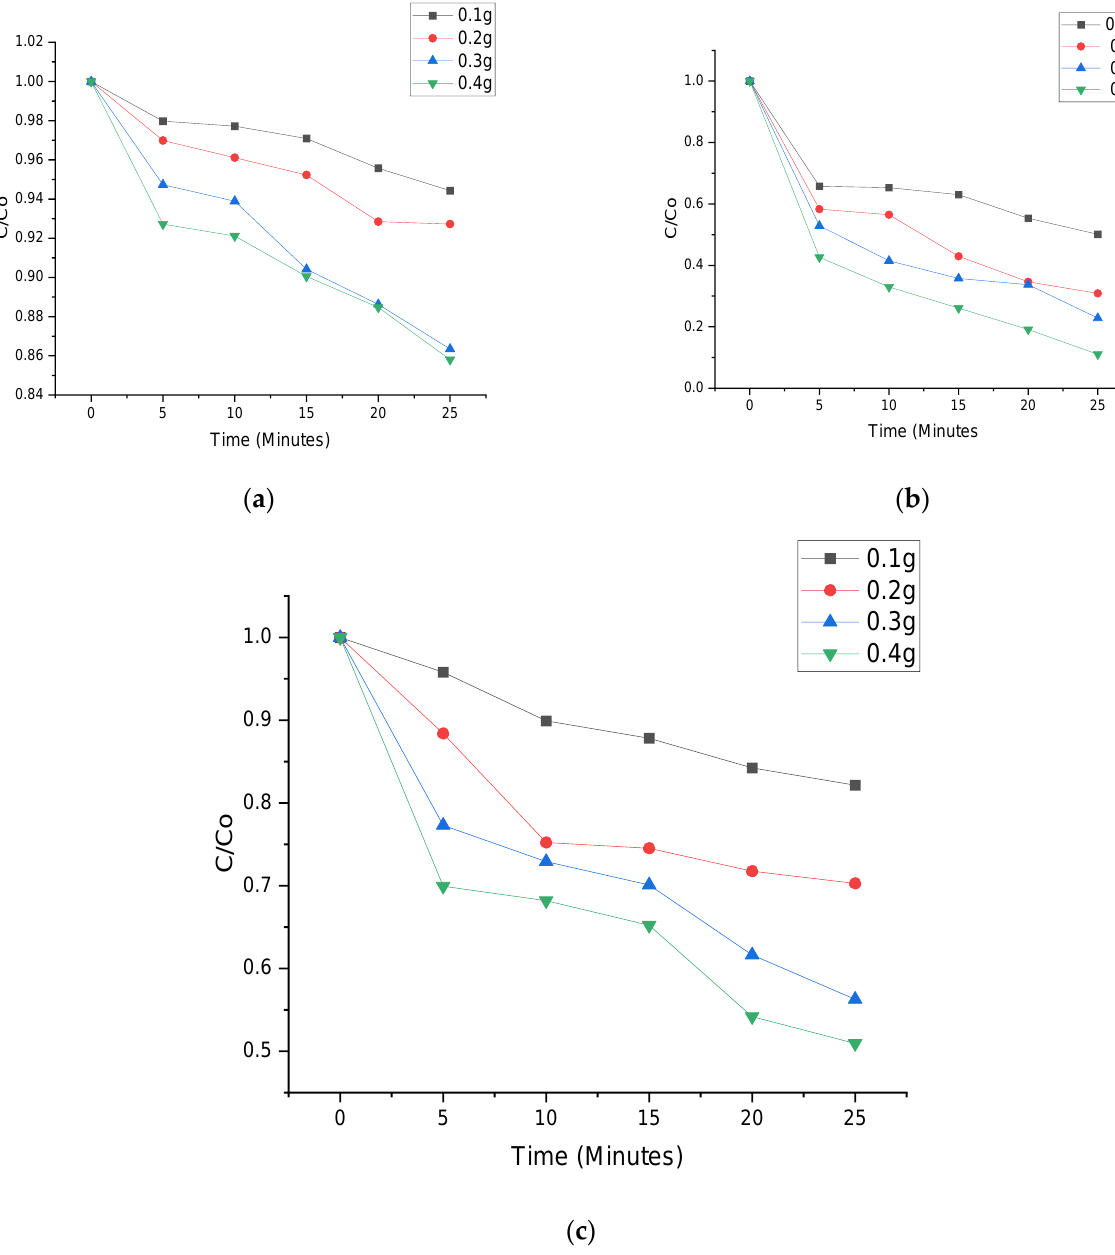
Figure 7. Photo degradation of ( a ) nitenpyram; ( b ) Tetracycline; and ( c ) sulfamethoxazole by Core shell @C 3 N 4 /ZnO.